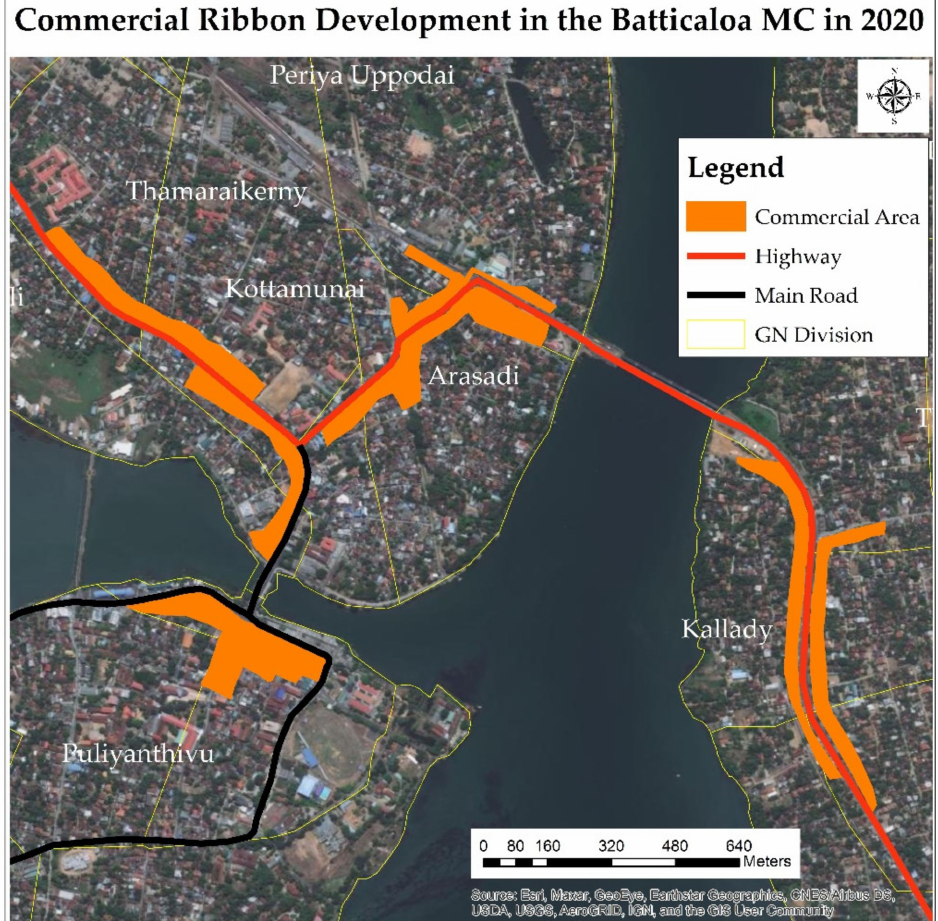
Figure 10. Commercial Ribbon Development in the Batticaloa